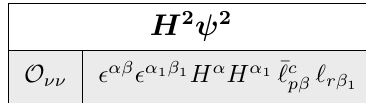
Table 6 . Single dimension-5 operator giving rise to neutrino masses.